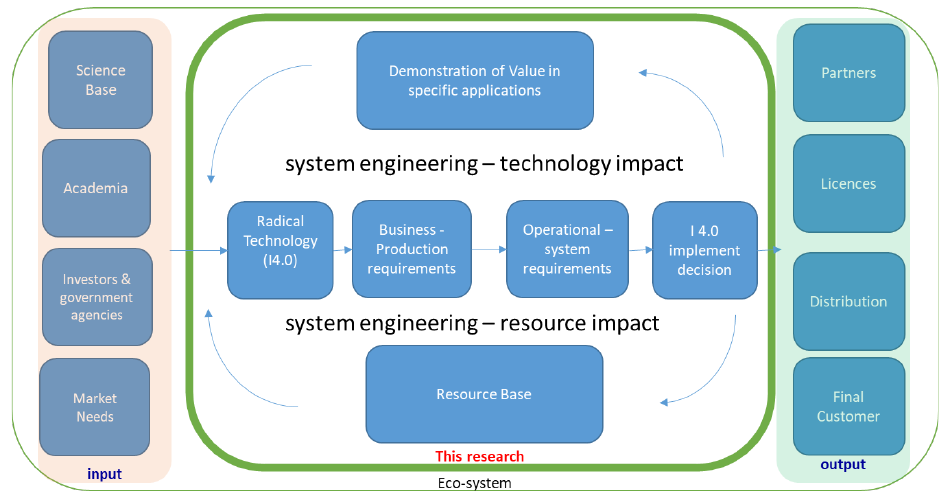
Figure 14. A company as a research focus.